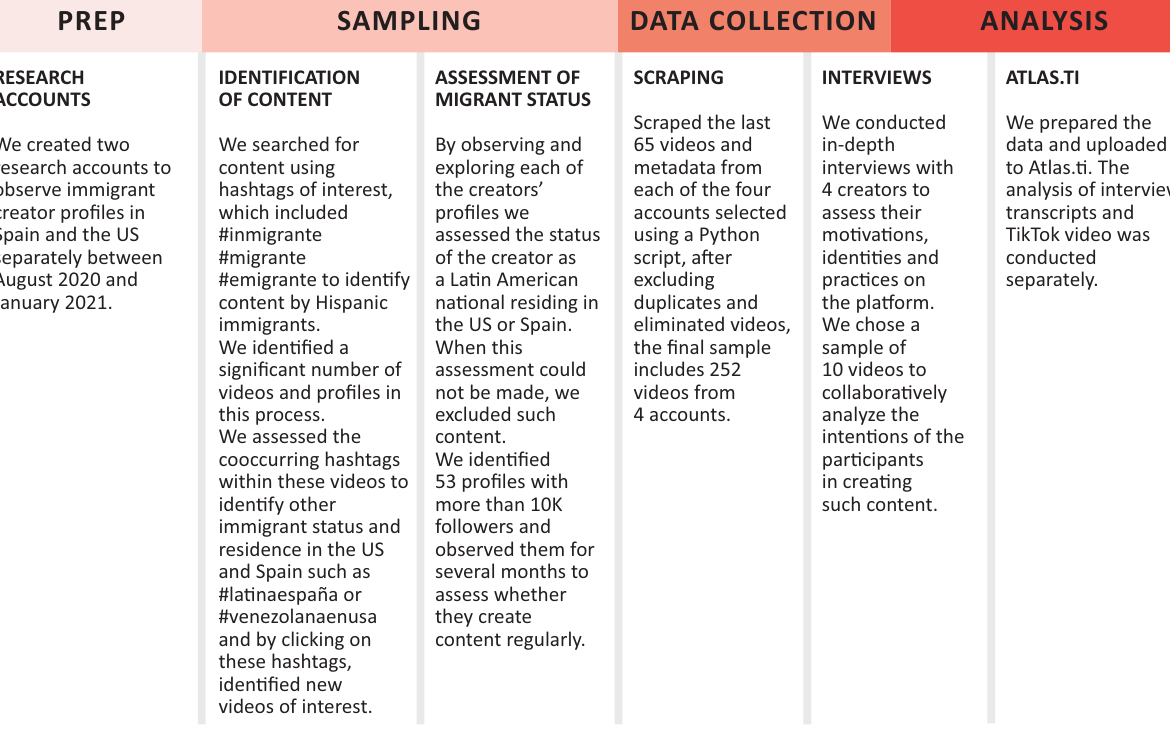
Figure 2. Research procedure.